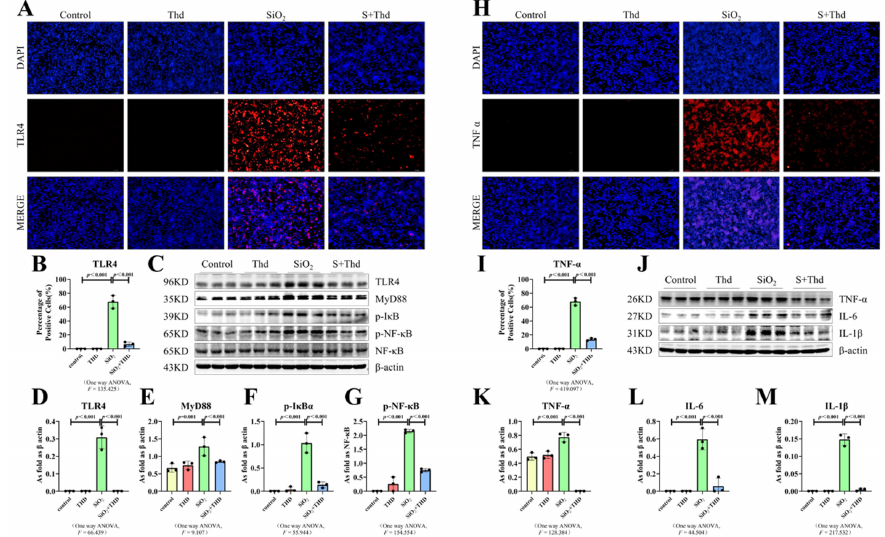
Figure 7. Thalidomide inhibited the TLR4-NF- κ B pathway and the expression of inflammatory factors in macrophages. ( A , B , H , I ) Expression of TLR4 and TNF- α in MH-S cells observed by IF staining (scale bar = 100 µm). ( C – G , J – M ) Protein expression of TLR4, MyD88, p-I κ B α , p-NF- κ B TNF- α , IL-6, and IL-1 β in MH-S cells treated with thalidomide, SiO 2 , and SiO 2 plus thalidomide measured by Western blot. Data are presented as the mean ± SD, n = 3 per group.